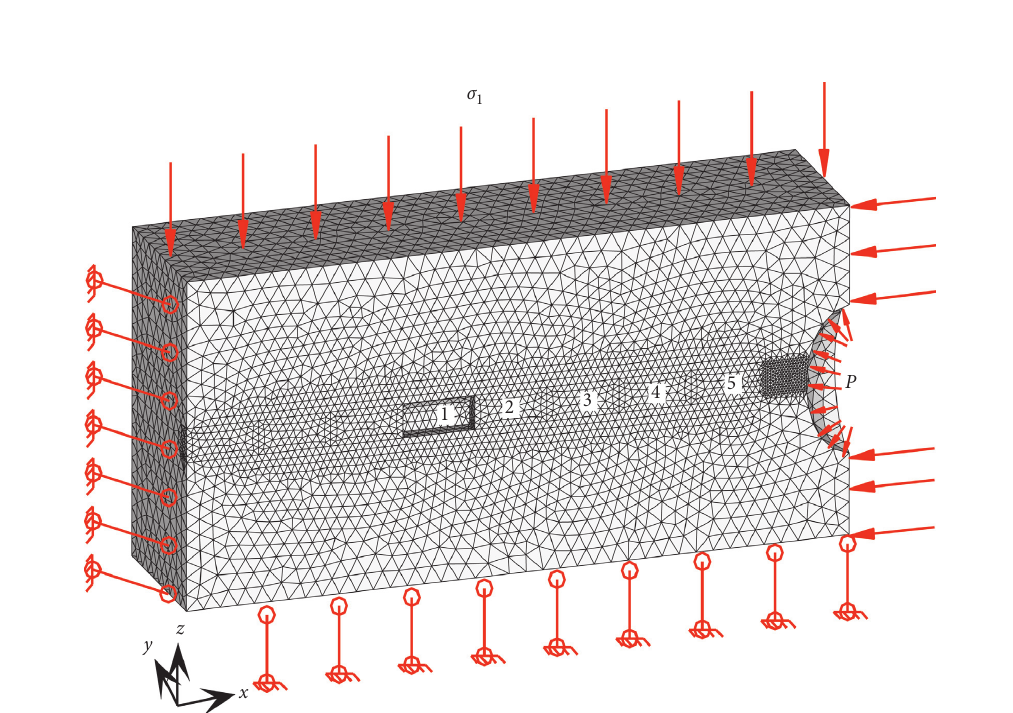
Figure 8: Numerical calculation